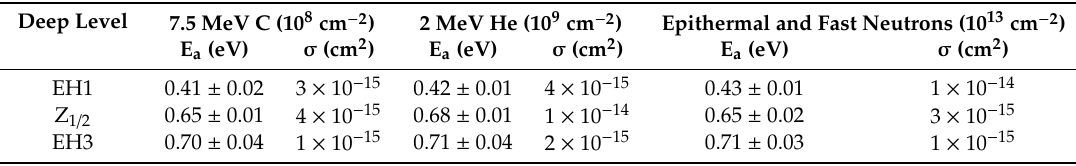
Table 1. Activation energies E a and apparent electron capture cross sections σ determined from DLTS measurements of ion implanted and neutron irradiated SBDs. Standard deviations of activation energies are included. Capture cross sections are within an order of magnitude of the calculated values. Deep Level